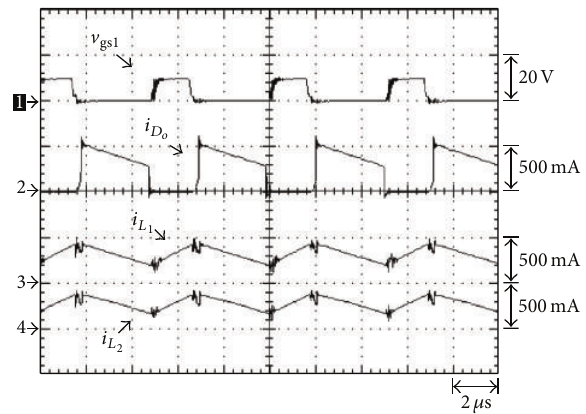
Figure10:Measuredwaveformsfortheproposedconverterwiththe proposed HMPPT method applied under illumination intensity of